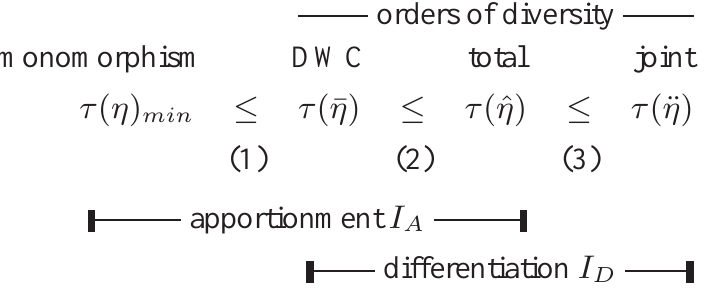
Table 3. Relations between the three orders of diversity (DWC, total, joint), the ranges of diversity orders covered by the apportionment and differentiation perspective and their indices I A and I D , and effects on diversity associated with the transitions between diversity orders.